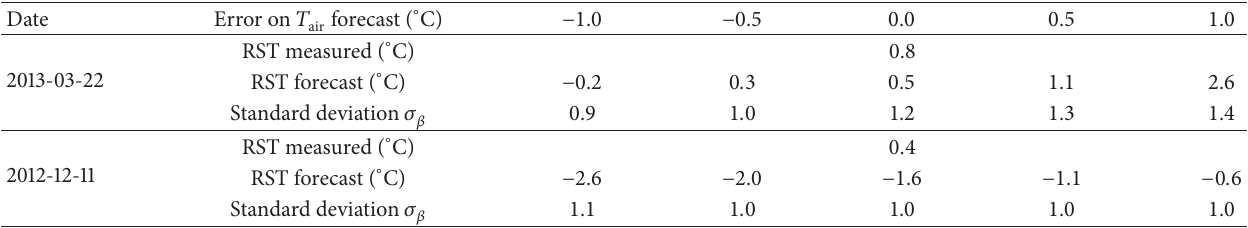
Table 6: Evaluation of error made on RST forecast with a PLS model (2 factors used out of 4 of the model based on 6 samples) with an error profiles for two of ± 1 ∘ C on 𝑇 air